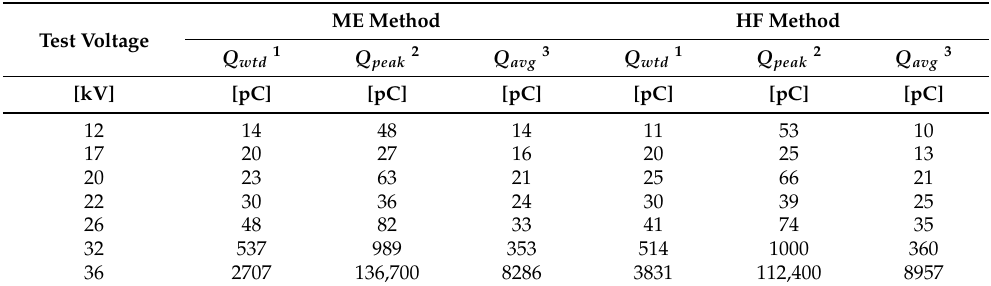
Table 4. Measurement results of Q depending on U p for the XRUHAKXS 1 × 240/25 cable without installed corona rings.